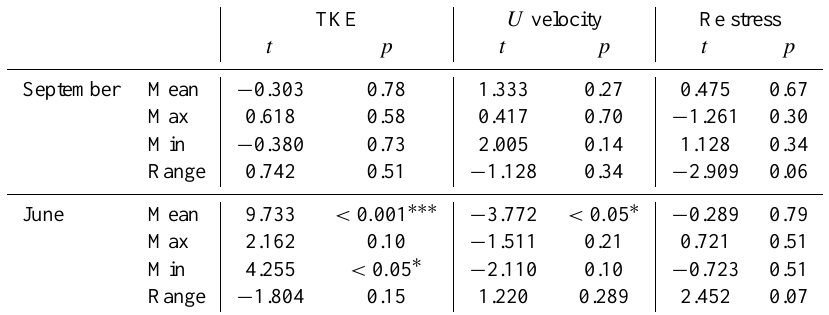
June Mean < 0 . 001